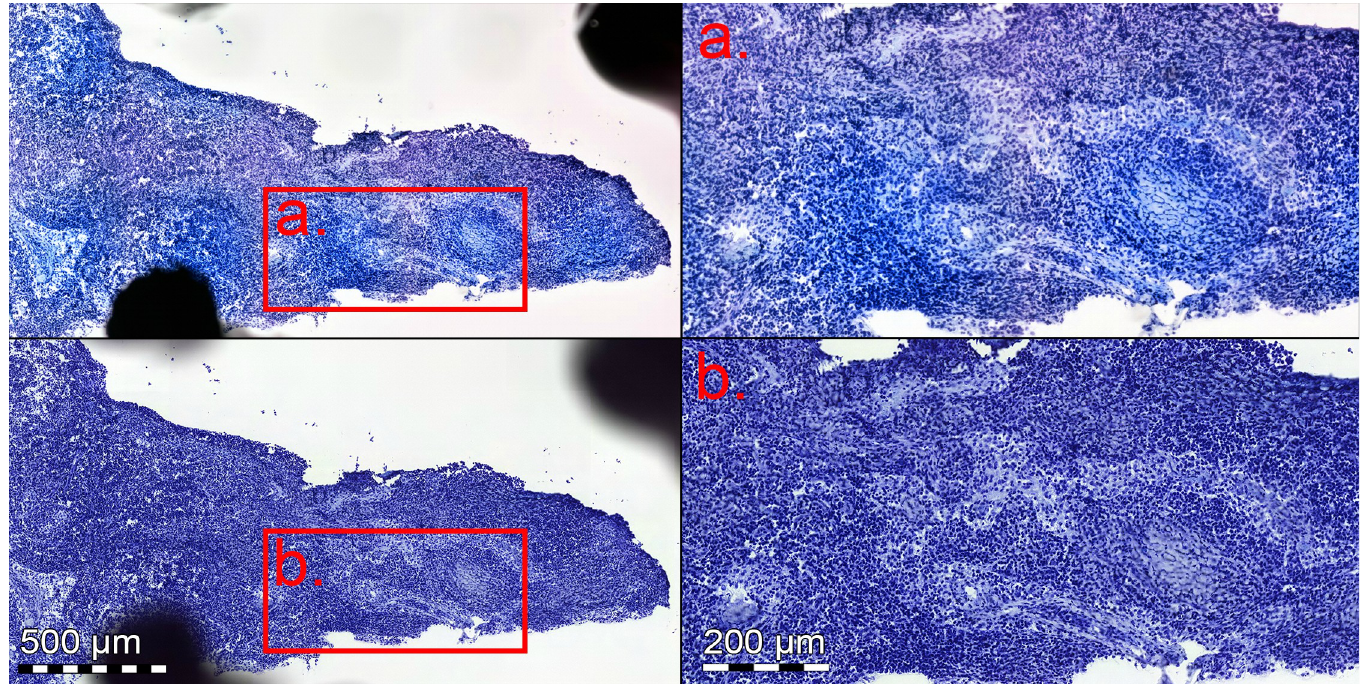
Fig 4. Toluidine blue stained frozen sections with micrometastasis. Slide scanned with the miniature microscope scanner (upper images), and reference slide scanner (lower images). Anti-cytokeratin staining was not available for this section, making analysis challenging, and sample was incorrectly classified as negative by both experts, regardless of device used for digitization.